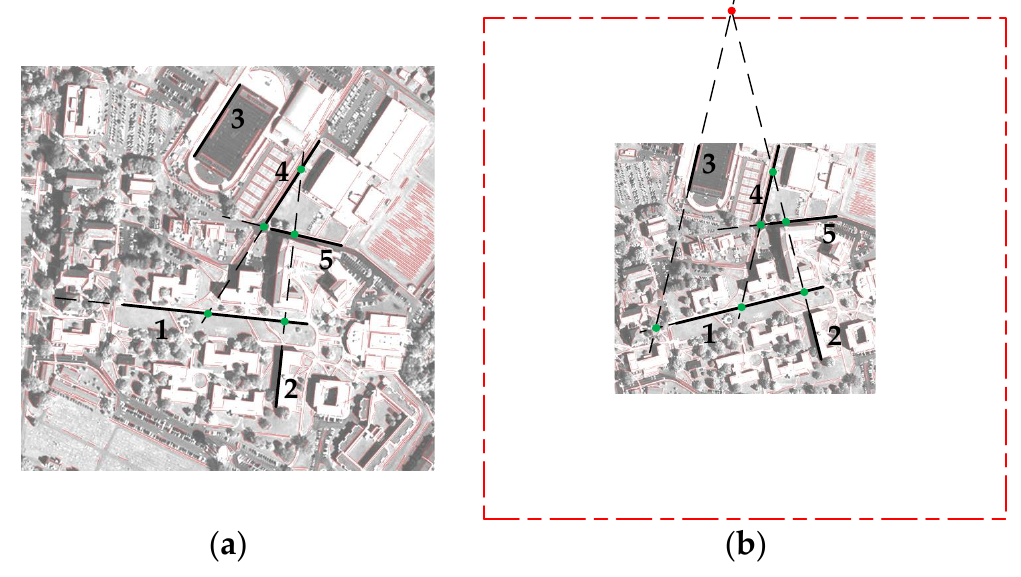
Figure 6. Illustration of generating intersections using matching lines. ( a ) Test image with several line segments; ( b ) Reference image with corresponding line segments. The location constraint of intersections is marked as a red rectangular area (only shown in reference image in this example). Intersections satisfying the constraint are in green, otherwise in